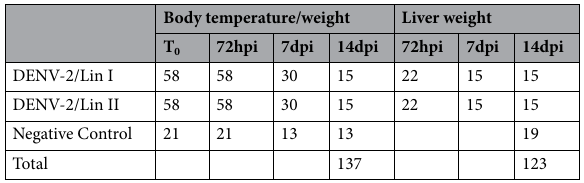
Table 2. Number of mice used for clinical analysis and liver weight analysis. T 0 : before infection, hpi: hours post infection, dpi: days post infection, Lin: Lineage.